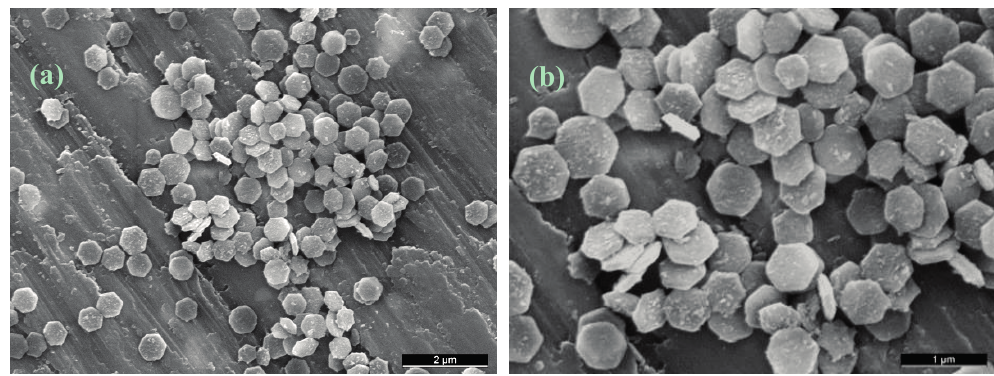
Figure 6. SEM images, ( a ) 10 kX and ( b ) 20 kX magnification, of β -TCP platelets produced in the SFTR reactor in ethylene glycol (EG) at 170